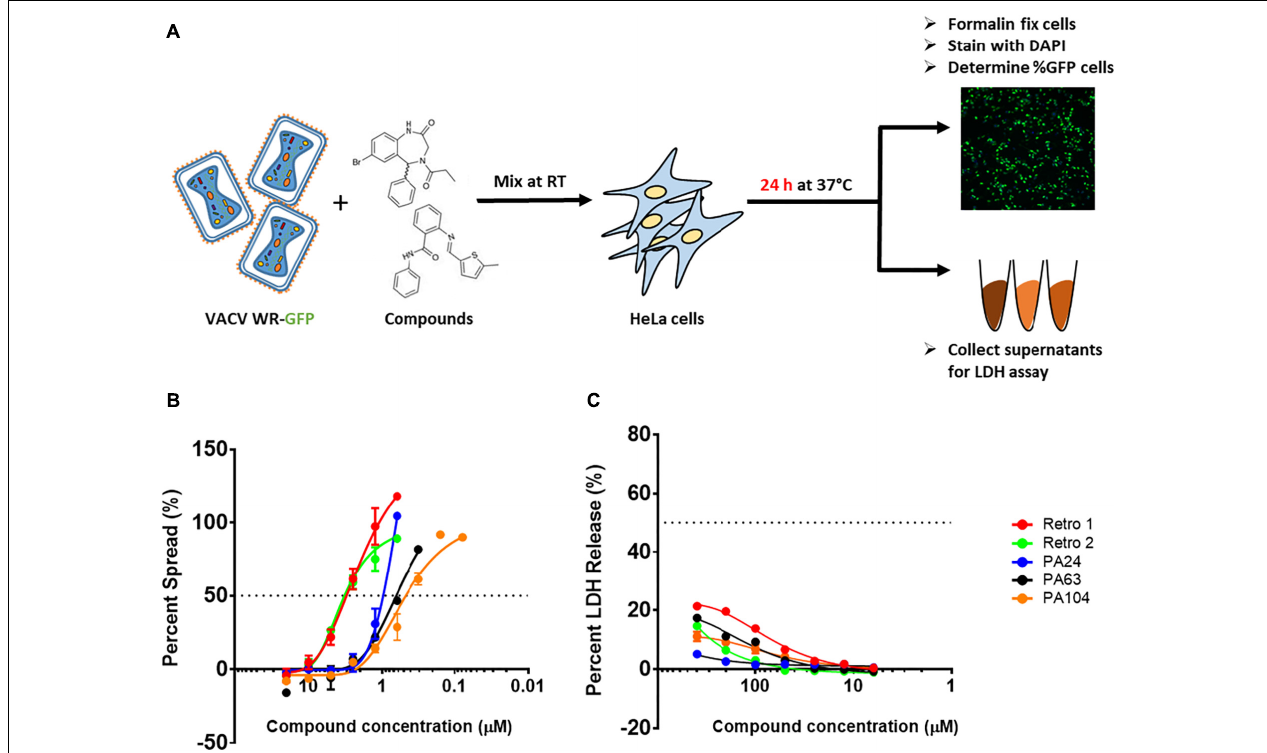
FIGURE 1 | Structural analogs of Retro-1 can inhibit VACV spread with minimal cytotoxicity. (A) Schematic representation of steps used to determine viral spread and cellular toxicity in the presence of Retro-1 analogs. The virus spread and cytotoxicity assays were performed twice for each compound, in duplicate. (B) Representative graph showing percent viral spread in the presence of a serial dilution series of five retrograde inhibitors. Values plotted represent the average of two independent experiments. (C) Representative graph showing percent LDH release in the presence of a serial dilution series of five retrograde inhibitors. Values plotted represent the average ± SEM from two independent